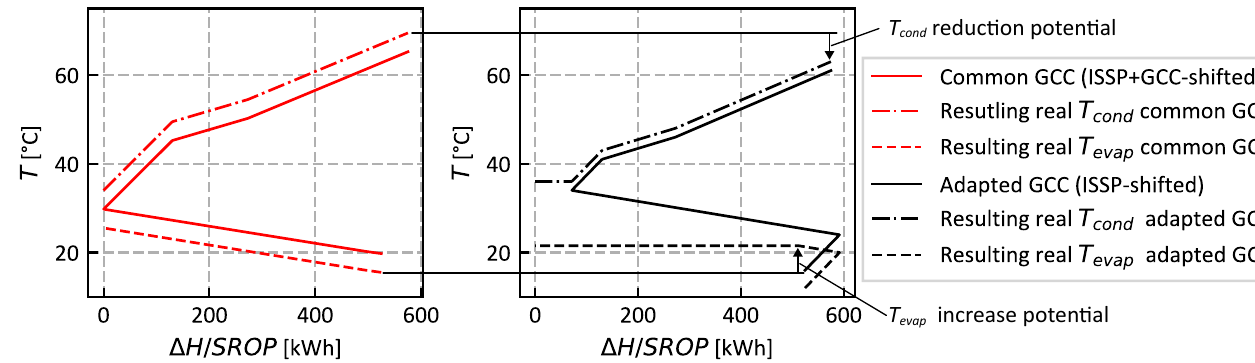
Figure 5. Resulting real T cond and T evap of the correctly integrated HP if (i) the HP is integrated with GCC as calculated for continuous processes (Townsend and Linnhoff [1], red lines) and (ii) the HP is integrated with the adapted GCC (black lines). The potential reduction in temperature increase when using the proposed adapted GCC is highlighted. Data taken from Demonstration Case with an IHR overlap of 80 kWh.